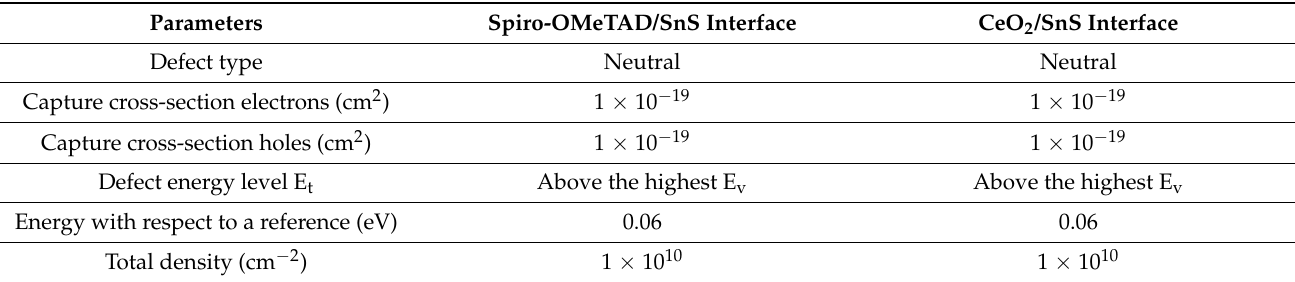
Figure 1. ( a ) Schematic layout of the proposed heterostructure solar cell and ( b ) the energy band diagram of the proposed heterostructure solar cell. Table 2. Interface values are employed in the device